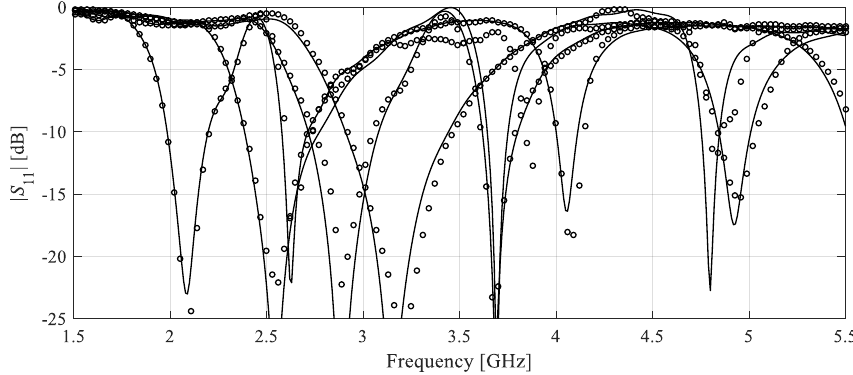
Figure 8. Dipole antenna: reflection responses at the selected test designs: EM model ( — ), nested kriging with variable-thickness domain obtained using 400 training samples and T max = 0.02 (o).